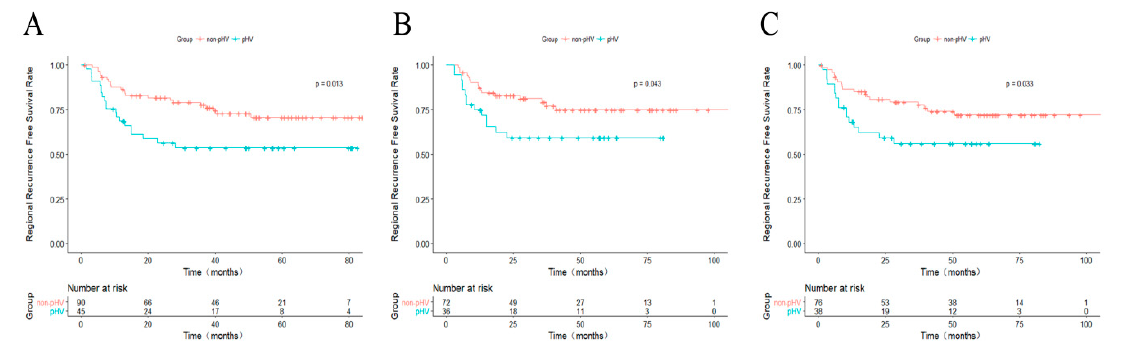
Figure 4. Kaplan–Meier curves comparing rRFS between non-pHV and pHV HCC patients after propensity score-match. ( A ) For all cases; ( B ) For HCCs smaller than 3 cm; ( C ) For initially diagnosed HCCs. rRFS: regional recurrence-free survival; HCC: hepatocellular carcinoma; pHV: peri-hepatic vein.